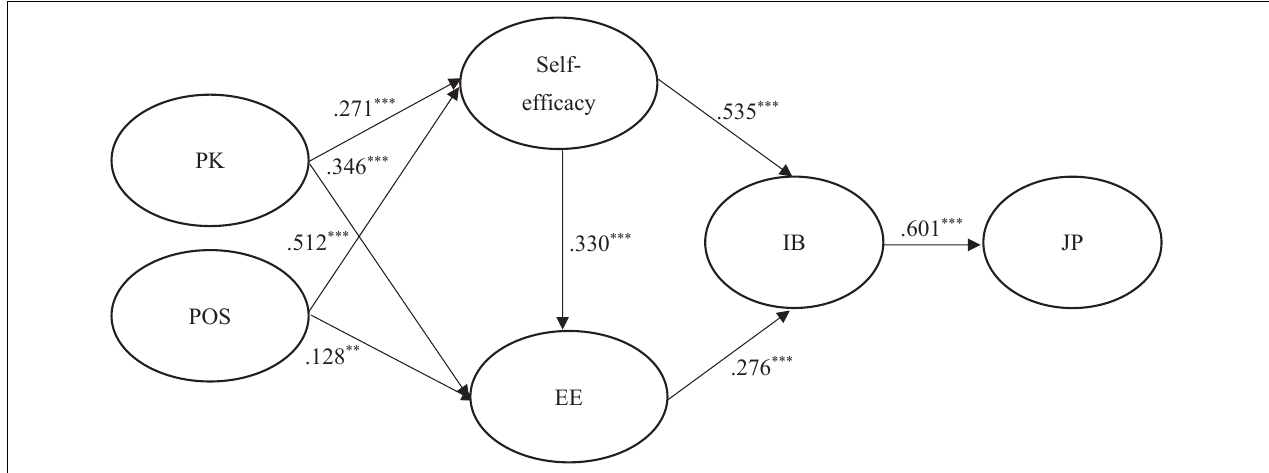
FIGURE 2 | Structural model on Taiwanese employees. PK, prior knowledge; POS, perceived organizational support; EE, employee employability; IB, innovation behavior; JP, job performance. *** p < 0.001.